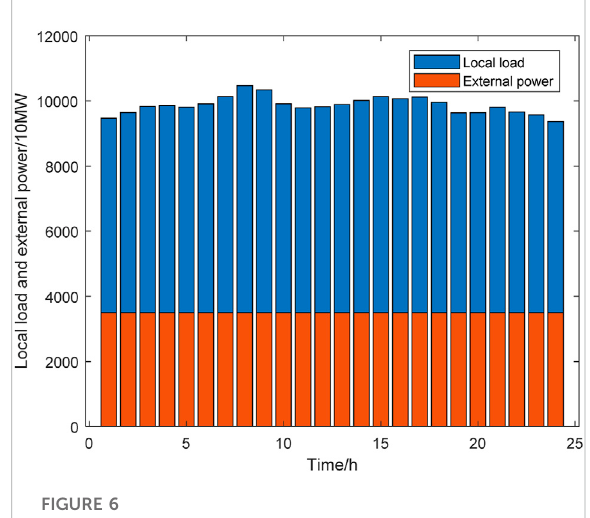
FIGURE 6 Local load and external power on typical day 1.